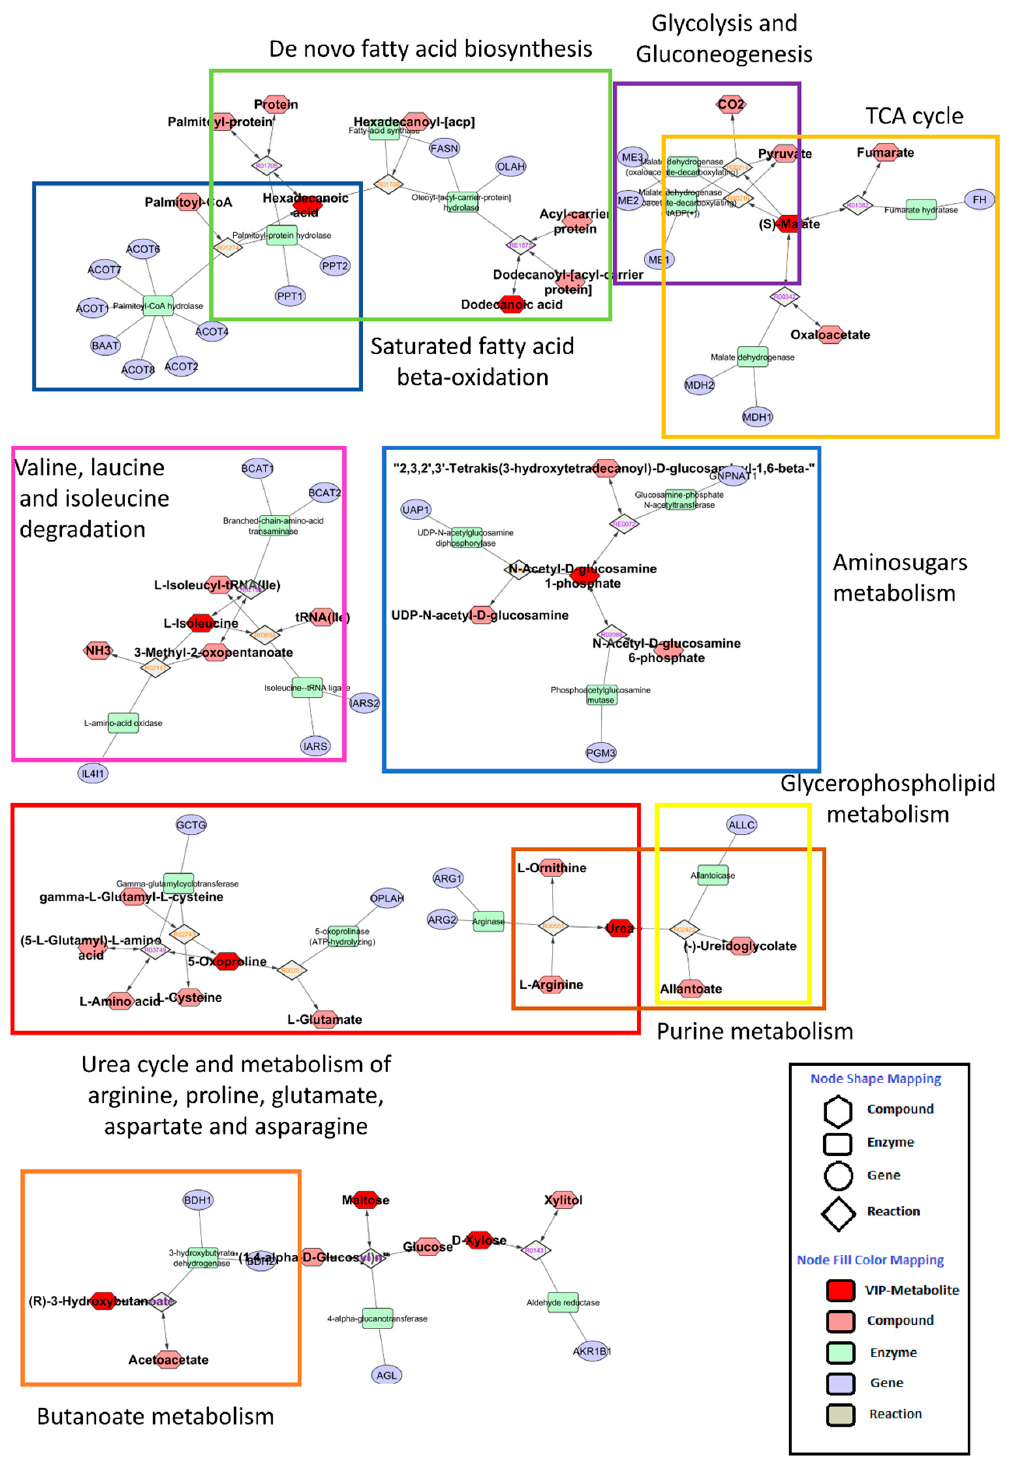
Figure 5. Metabolic systems map summarizing the shortest route that may explain the interactions among the metabolites with a variable important in projection scores higher than 2. There is a clear interplay of several pathways involving: de novo fatty acid biosynthesis; saturated fatty acid beta-oxidation; butanoate metabolism; glycolysis and gluconeogenesis; tricarboxylic acid cycle (TCA); urea cycle and metabolism of proline, glutamate, aspartate and asparagine; valine, and isoleucine (branched chain amino acids) degradation; aminosugars metabolism; purine metabolism; glycerophospholipid